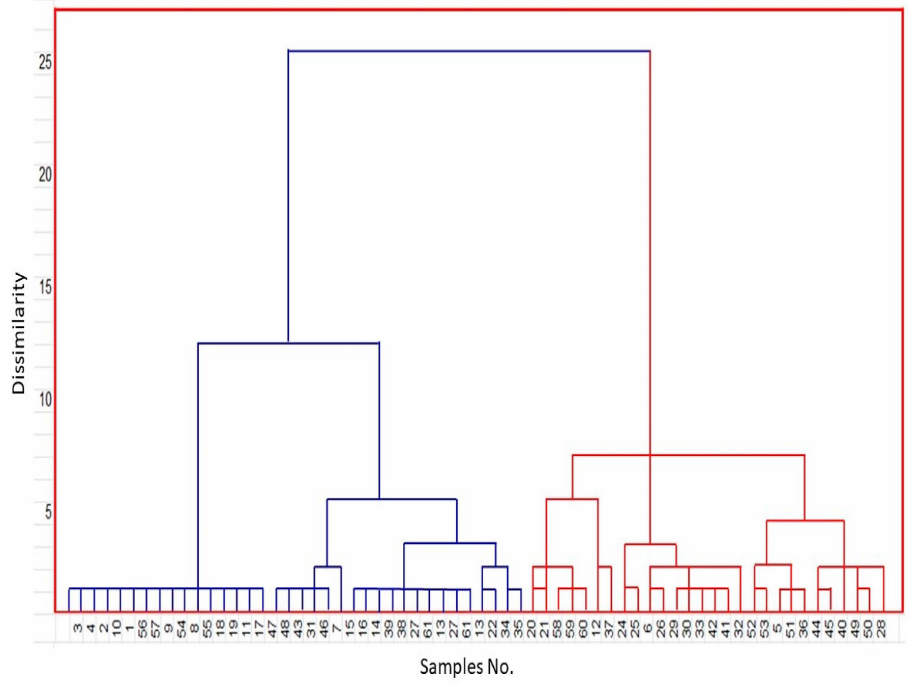
Figure 5. Dendrogram for the grouping